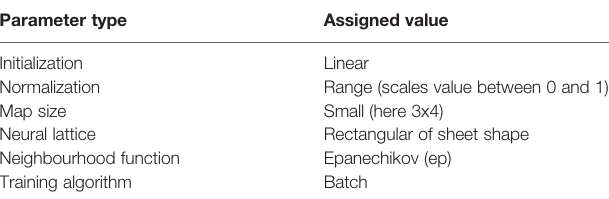
TABLE 1 | SOM parameters and their optimal assigned values based on Liu et al.